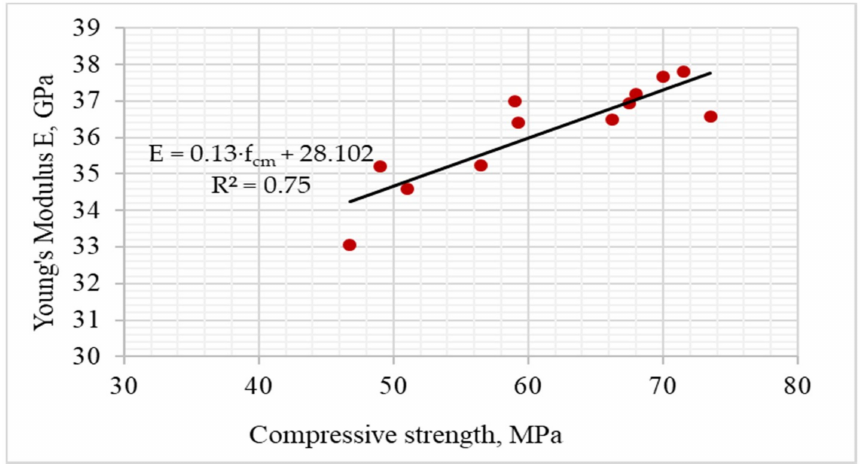
Figure 9. Relationship between the Young’s Modulus for the individual series and the compressive strength of